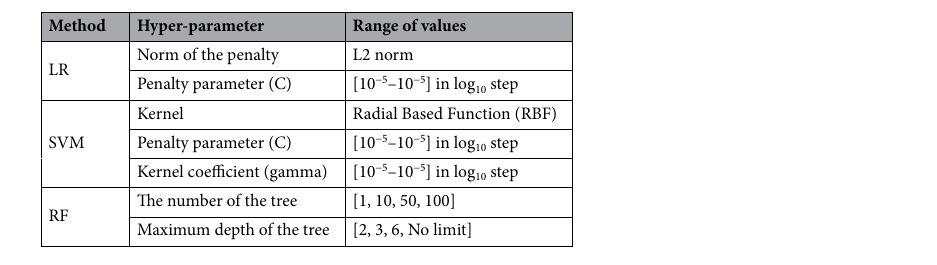
Table 1. List of the hyper-parameter